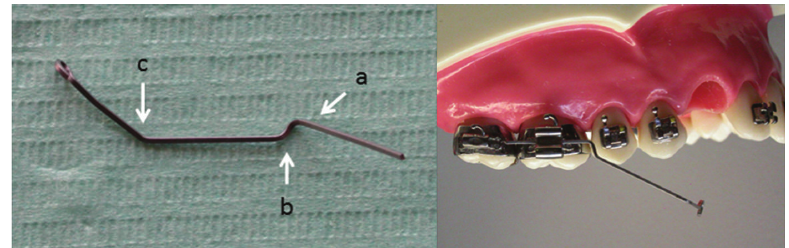
Figure 4: A cantilever modelled using .019 󸀠󸀠 ×.025 󸀠󸀠 TMA. Initially, a first order—offset (a) and a second order (b) bends are modelled close to the maxillary molar to avoid interferences with premolar brackets and to activate the cantilever. Then, a first order bend (c) directed palatally is used to anchor the canine .